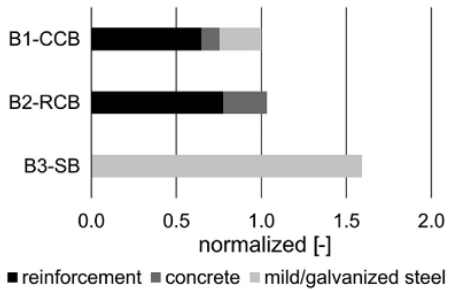
Figure 10. Comparison of the GWP of various pedestrian bridge types (normalized values) divided by the used building materials, extracted from [5].